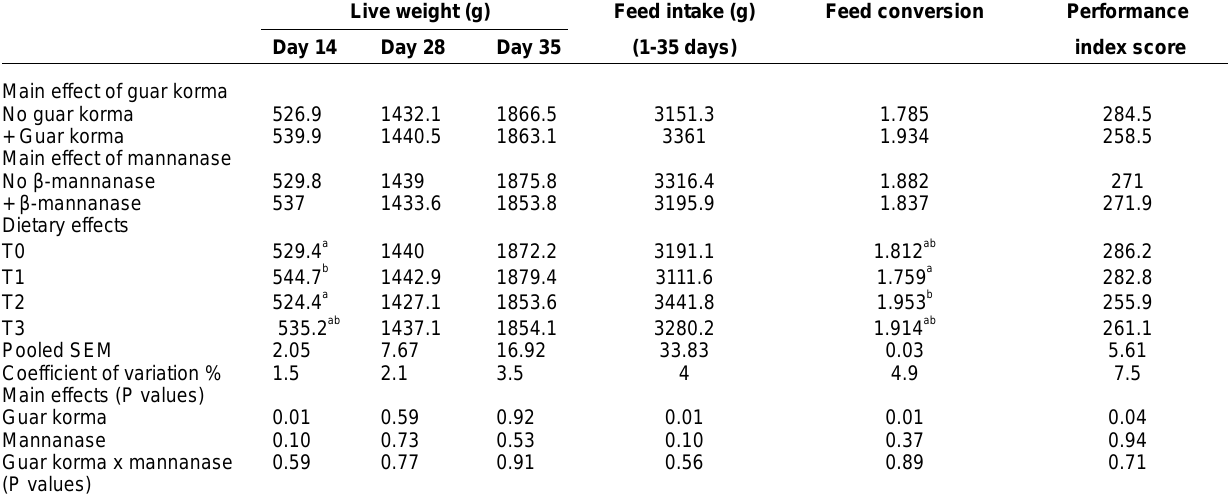
Table-2. Effect of guar korma and β-mannanase on